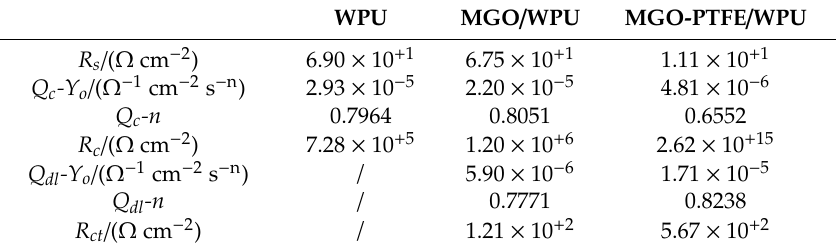
Table 4. Fitting data of pure WPU coating, 1.5 wt.% MGO / WPU composite coating and 1.5 wt.% MGO-PTFE / WPU composite